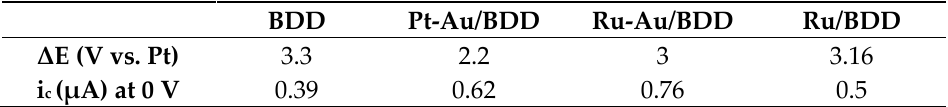
Figure 1. SEM pictures of polycrystalline BDD electrode surface before and after metal NPs deposition. Table 1. Potential window recorded within the range of current threshold ± 100 µA and capacitive current recorded at 0 V vs. Pt for the bare diamond electrode and the BDD electrodes modified with metal nanoparticles.